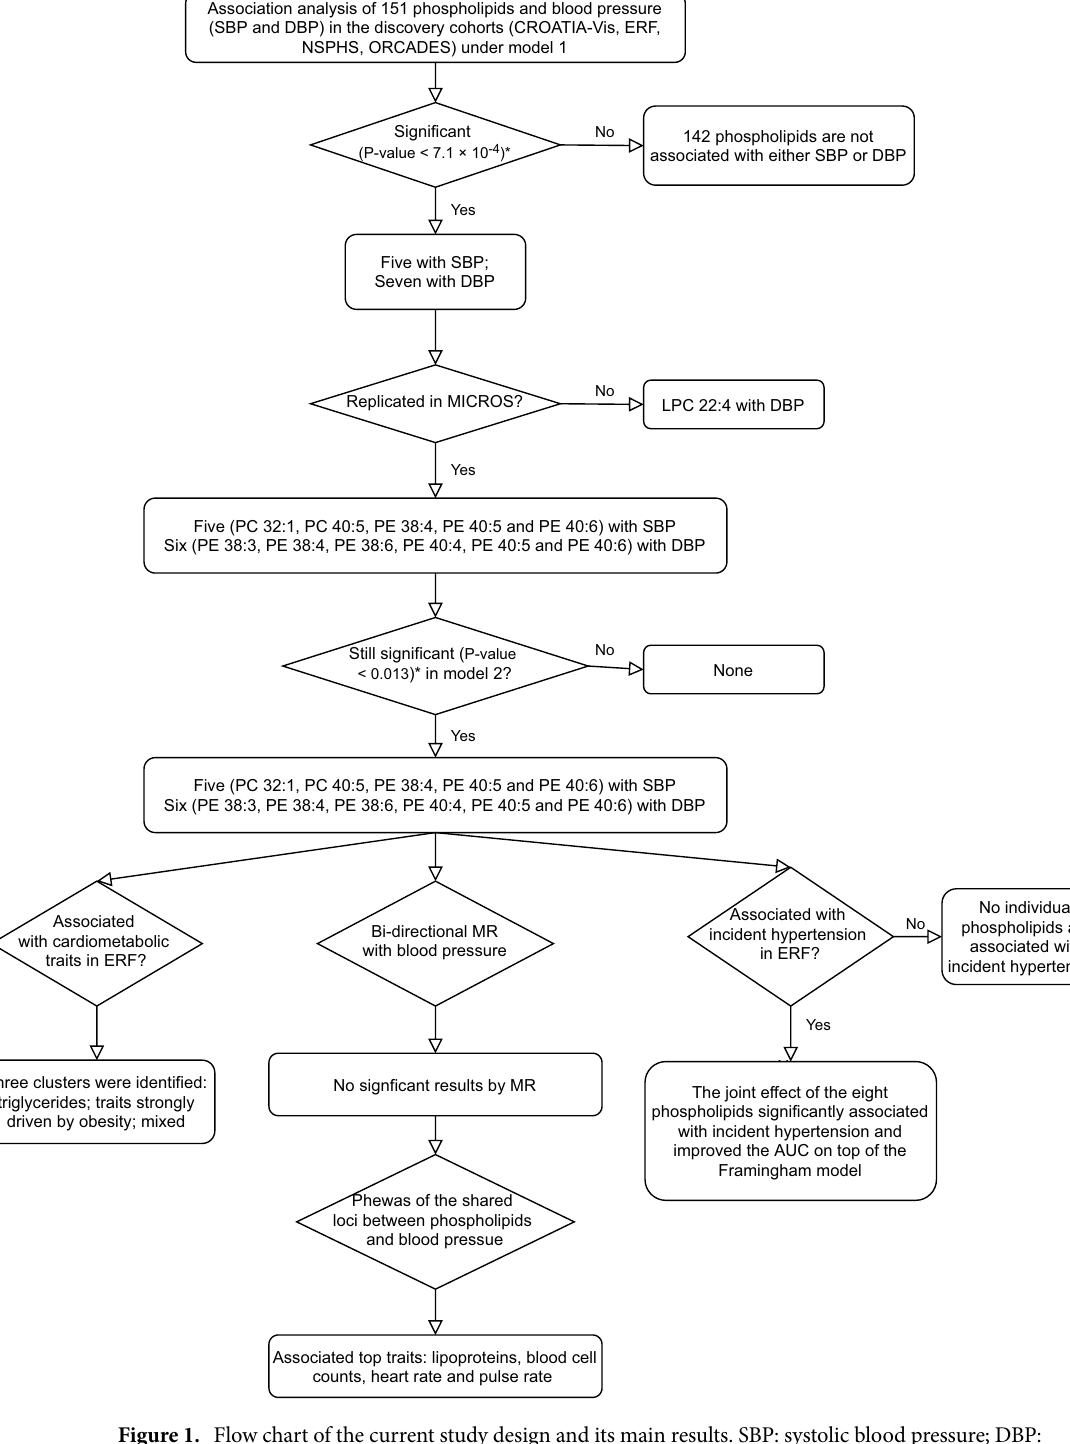
Figure 1. Flow chart of the current study design and its main results. SBP: systolic blood pressure; DBP: diastolic blood pressure; PC: phosphatidylcholines; PE: phosphatidylethanolamines; MR: Mendelian randomization; AUC: area under the ROC curve; Phewas: phenome-wide association study; * Bonferroni correction for the independent number of